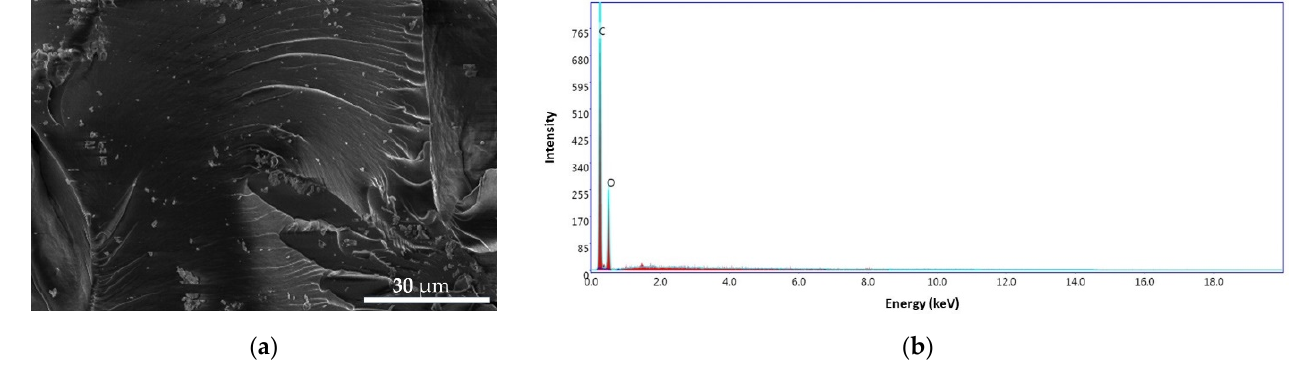
Figure 14. SEM images for CS microbeads at 4000× ( a ), EDS pattern ( b ).